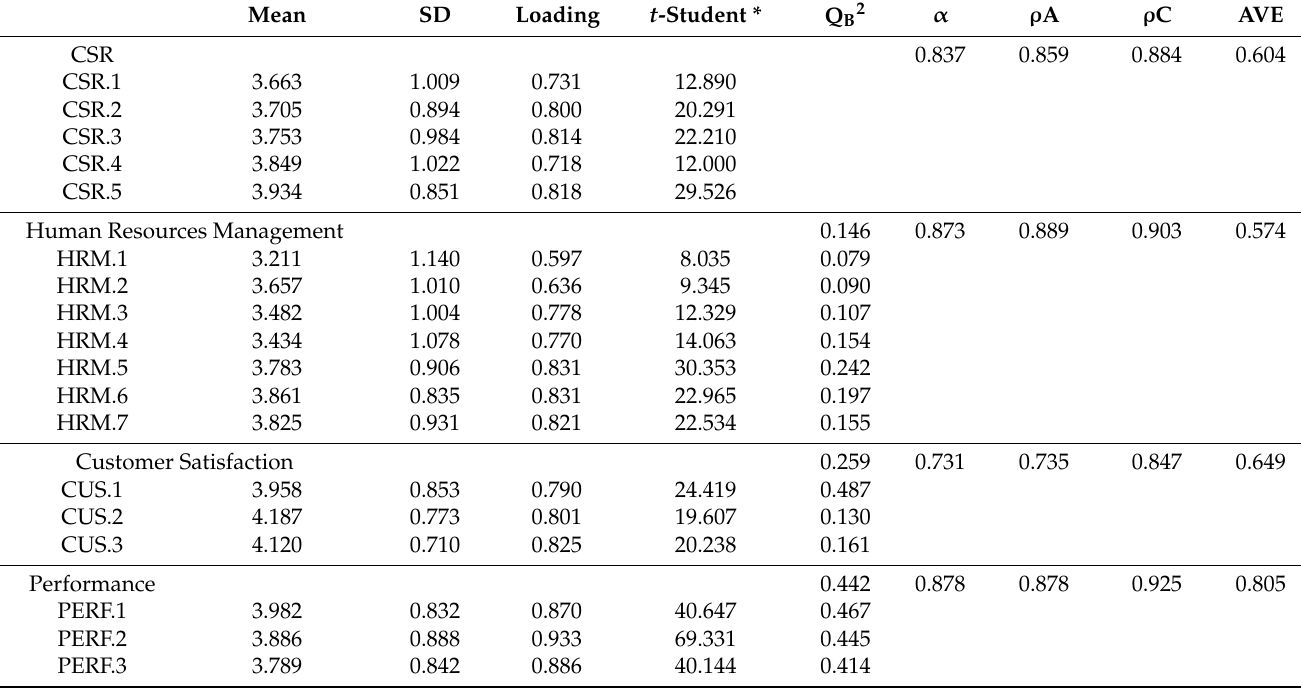
Table 2. Outer model results for 18 indicators corresponding to four